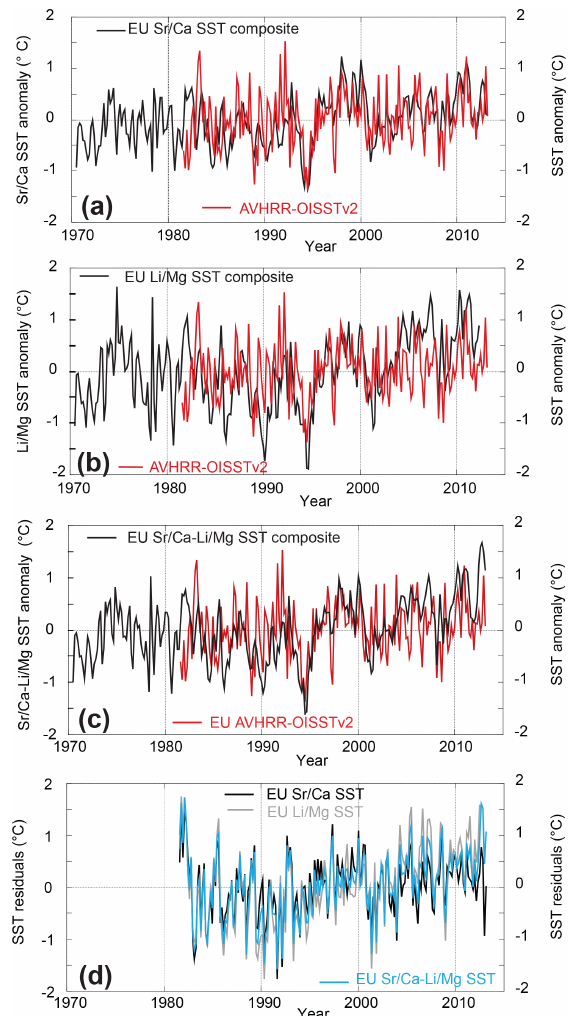
Figure 7. SST anomaly reconstructions with SST residuals for (a) EU composite Sr / Ca, (b) EU composite Li / Mg, and (c) their combination for cores EU2 and EU3. (d) Residuals for SST anoma- lies of Sr / Ca SST, Li / Mg SST, and their combination for cores EU2 and EU3 with respect to the AVHRR-OISSTv2 data (Banzon et al., 2016). Anomalies were calculated relative to the 1981 to 2010 av- erage bimonthly seasonal